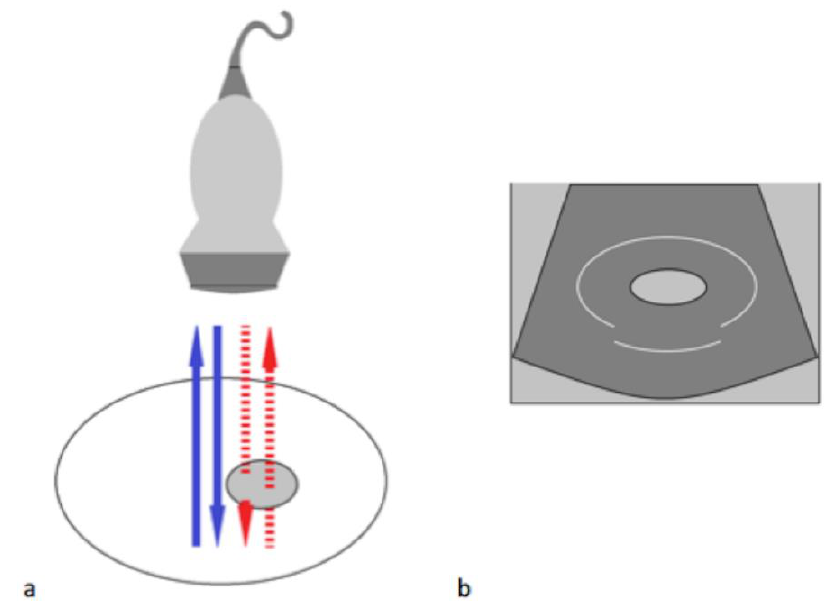
Figure 6. Speed displacement artifact. ( a ) In this diagram, the blue arrows represent the expected reflected path of the US beam. The red dashed arrows represent the path of an US beam that encounters an area of focal fat travelling slower than in the surrounding tissue. ( b ) Because the round trip of this echo is longer than expected, the posterior wall is displaced deeper on the display. Modified from Feldman MK et al. [5].